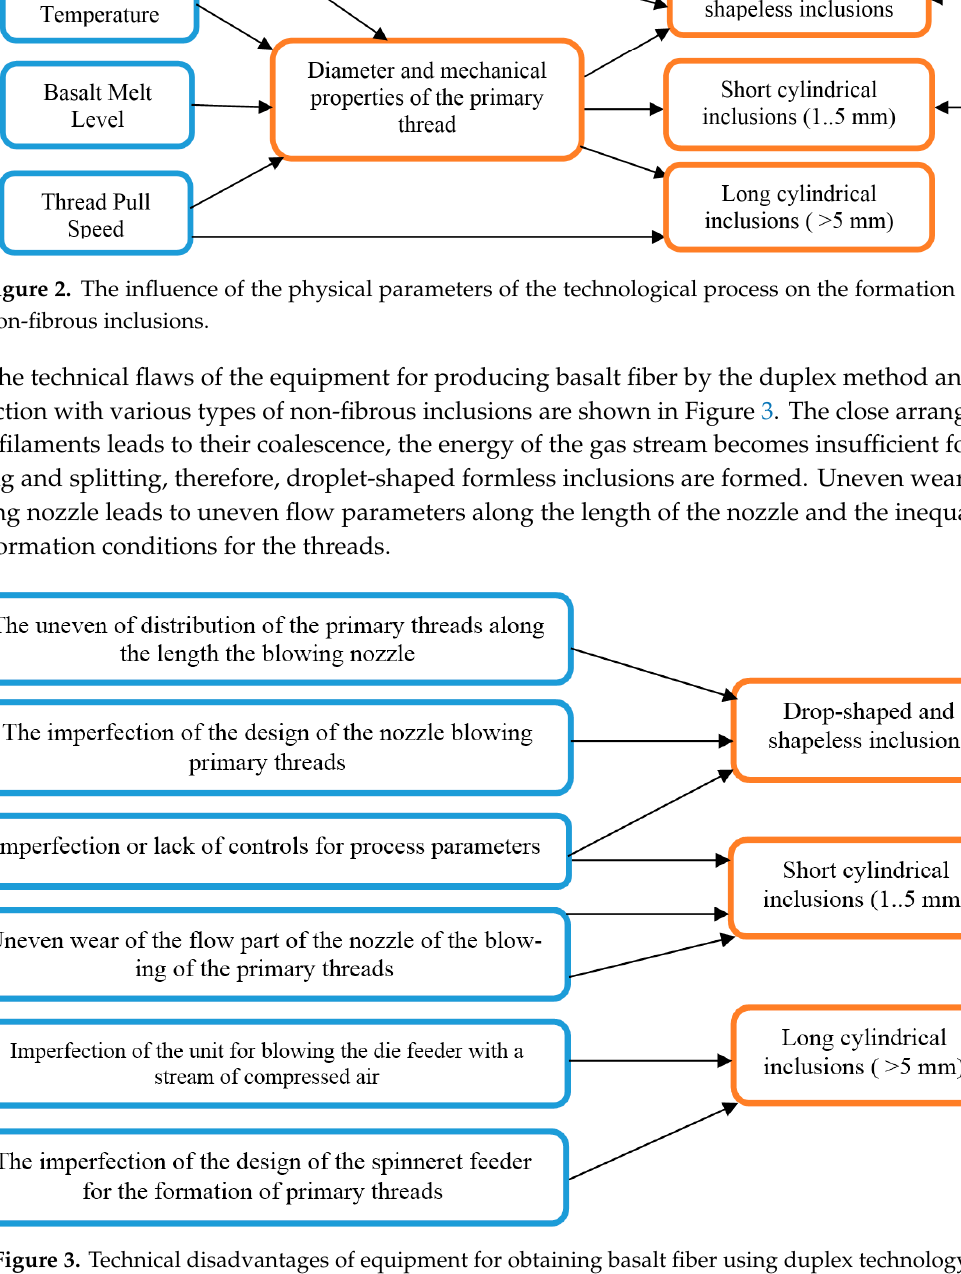
Figure 3. Technical disadvantages of equipment for obtaining basalt fiber using duplex technology.